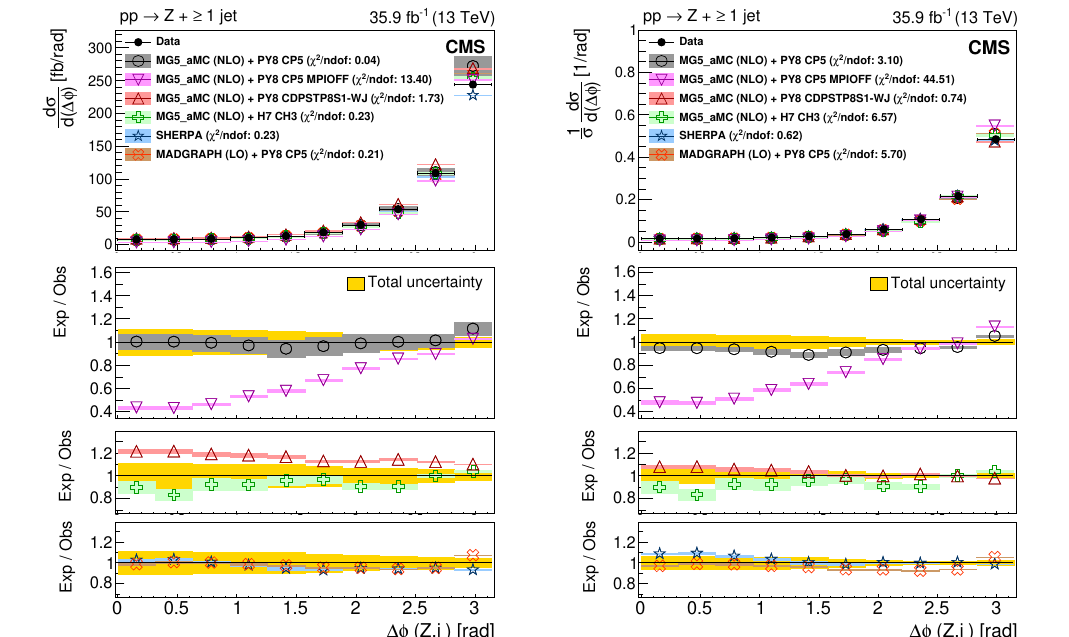
Figure 2 . Differential cross sections (left) and area-normalized distributions (right) as functions of ∆ φ between the Z boson and the leading jet for Z + ≥ 1 jet events. The uncertainties in the predictions are shown as coloured bands around the theoretical predictions including statistical, PDF, scale, and tune uncertainties for the NLO MG5_aMC + pythia 8 (with CP5 tune) and the statistical uncertainty only for the LO MG5_aMC + pythia 8 (with CP5 tune), NLO MG5_aMC + pythia 8 (with CDPSTP8S1-WJ tune, CP5 tune with MPI-OFF), NLO MG5_aMC + herwig 7 (with tune CH3), and sherpa predictions. In the top panel, the vertical bars on the data points represent statistical uncertainties, whereas in the bottom panels, the total uncertainty in data is indicated by the solid yellow band centred at 1. In the legend, the χ 2 per degree of freedom is given to quantify the goodness of fit of the model to the